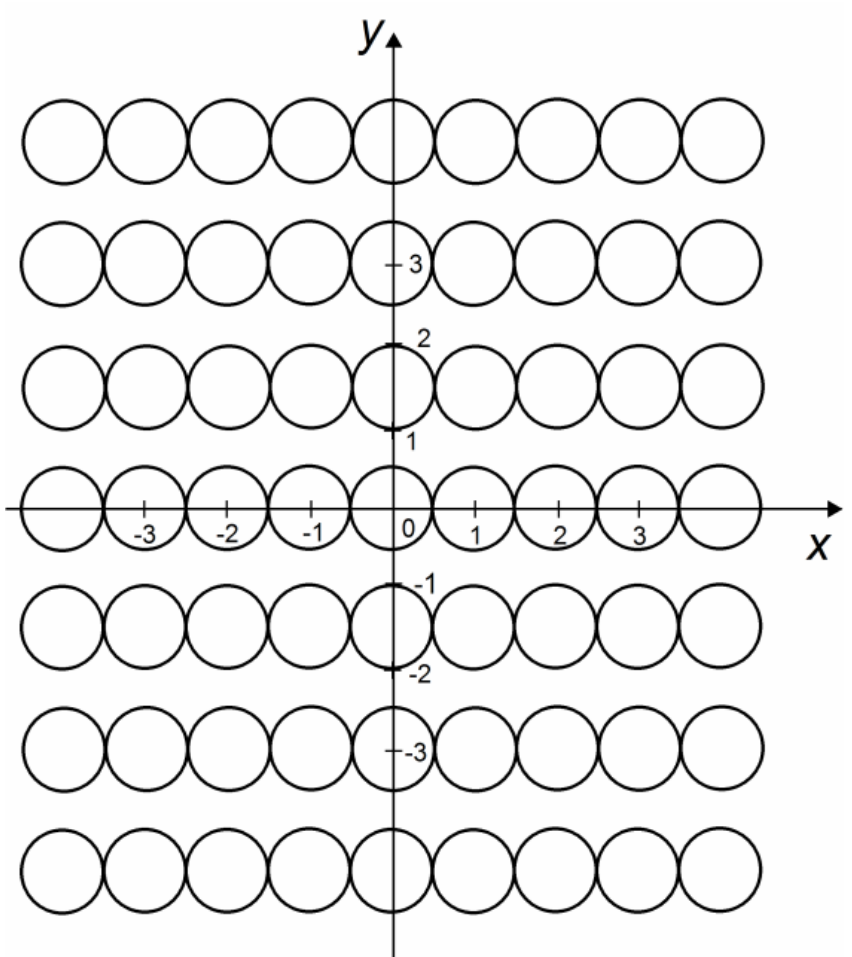
Figure 7. Arrangement of rings in the simulated system. Table 2. Numerical values used in calculations of the ground temperature field with an installed slinky-coil